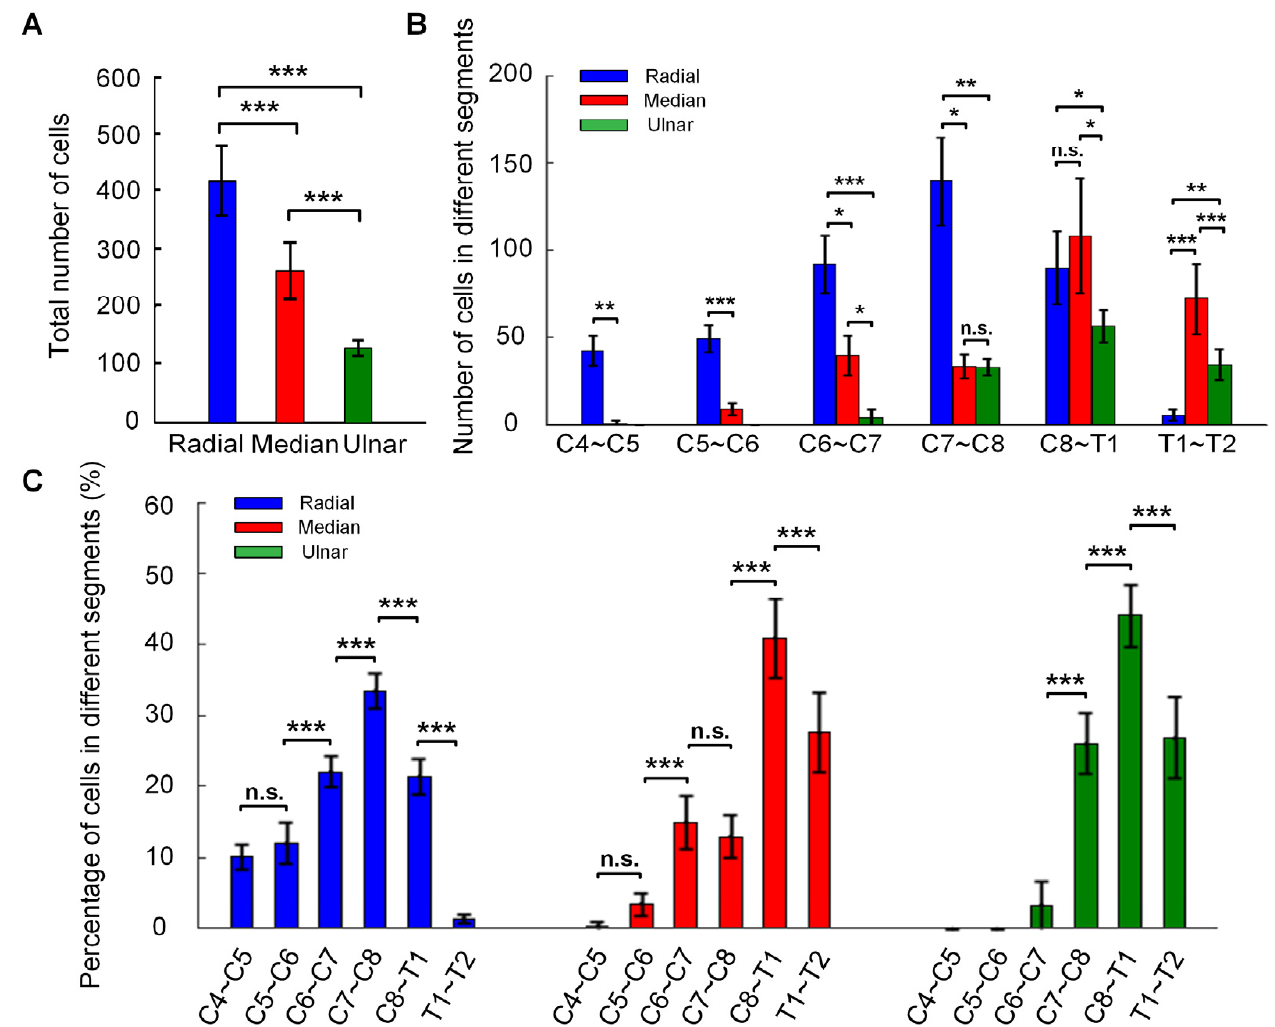
Figure 3. Quantification of motor neurons of ulnar, median, and radial nerves. ( A ) The total number of neurons of each nerve ( n = 6, one-way ANOVA, *** p < 0.001). ( B ) The number of neurons of each nerve in different spinal segments ( n = 6, one-way ANOVA and non-parametric test, n.s. represents no significance, * p < 0.05, ** p < 0.01, *** p < 0.001). ( C ) The percentage of neurons in different spinal segments of each nerve ( n = 6, one-way ANOVA, n.s. represents no significance, *** p < 0.001). The C4, C5, C6, C7, C8, T1, T2 represent the corresponding spinal nerve root. Data are presented as mean ± SD.